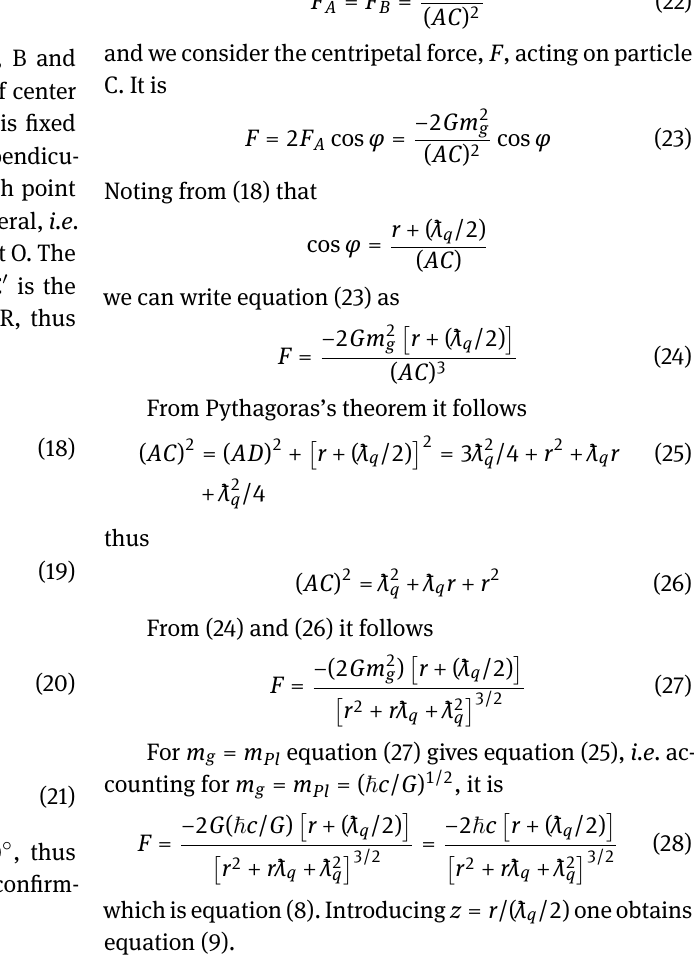
Figure 5: Model geometry: Particles A, B and C lie on the dotted circle with fixed distance (AB)= axis. When it is at point C * , the triangle ABC is